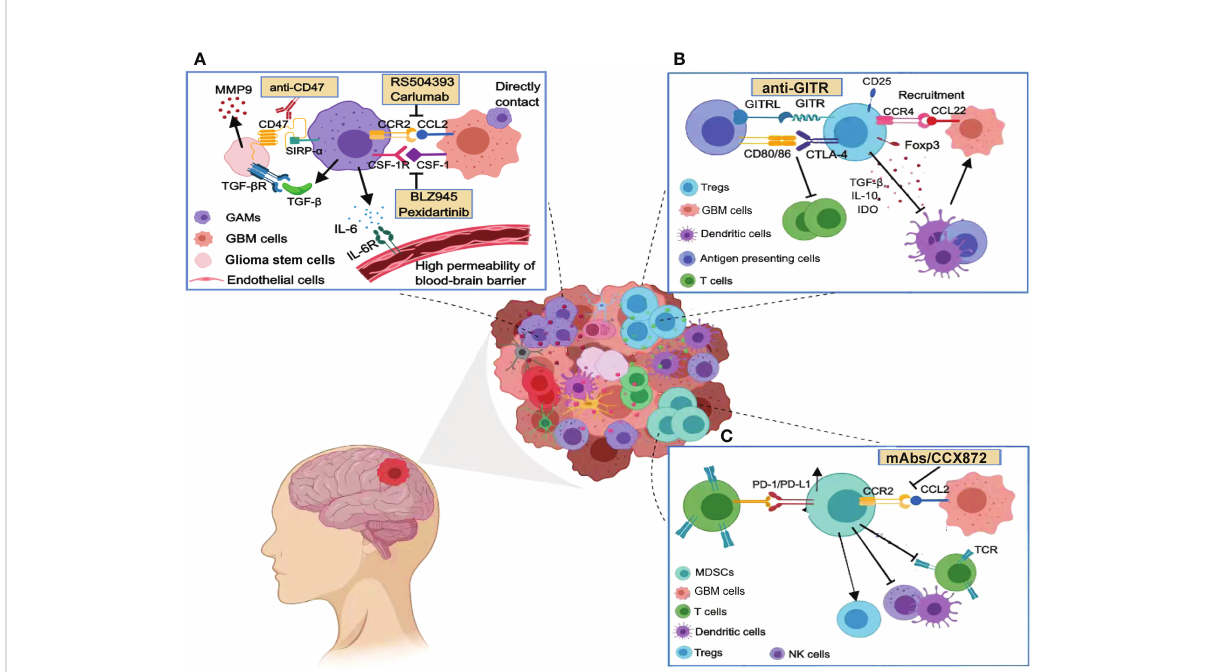
FIGURE 1 Immunosuppressive cells in the glioma microenvironment. (A) GAMs release many cytokines that promote the malignant phenotype of GBM and maintain the high permeability of the blood – brain barrier, including TGF- b , IL-6, and IL-1 b . Targeting the phagocytosis checkpoints such as CCL2/CCR2, CD47/SIRP- a , and the CSF-1/CSF-1R axis can enhance the phagocytosis of tumor cells by macrophages. (B) Tregs are recruited by chemokines and inhibit the action of cytotoxic T cells through immune checkpoints (e.g., CTLA-4 or GITR). Tregs release immunosuppressive cytokines such as TGF- b , IL-10, and IDO to inhibit dendritic cell function, disturbing a competent anti-tumor immune response. (C) MDSCs are also recruited by the CCL2/CCR2 axis in the GBM microenvironment and potently suppress anti-tumor immunity through PD1/PD-L1. MDSCs also deplete human essential amino acids, leading to impaired T-cell activation and